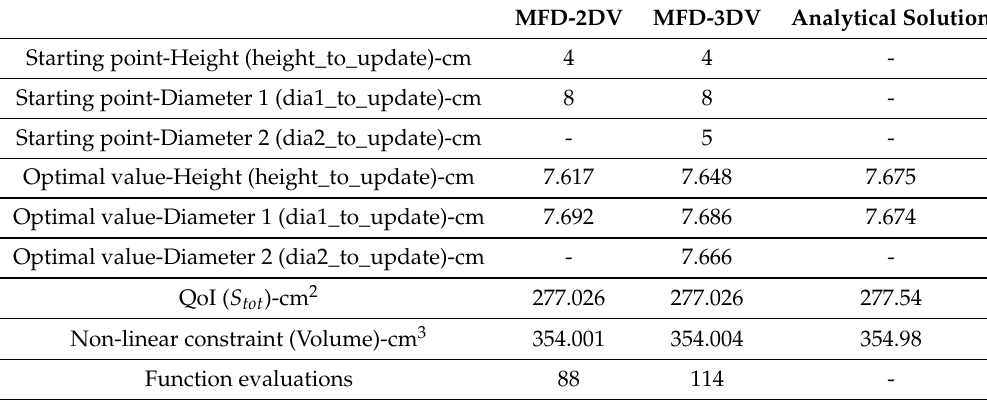
Figure 4. Onshape’s cloud-based client-server communication using RESTful API. The client communicates with Onshape’s server using Python API keys and OAuth authentication. Table 3. Outcome of the optimization study using a gradient-based method (MFD [34,35]). In the table, MFD-2DV refers to the case with two design variables. MFD-3DV refers to the case with three design variables. The case MFD-2DV uses the same diameter for the top and bottom